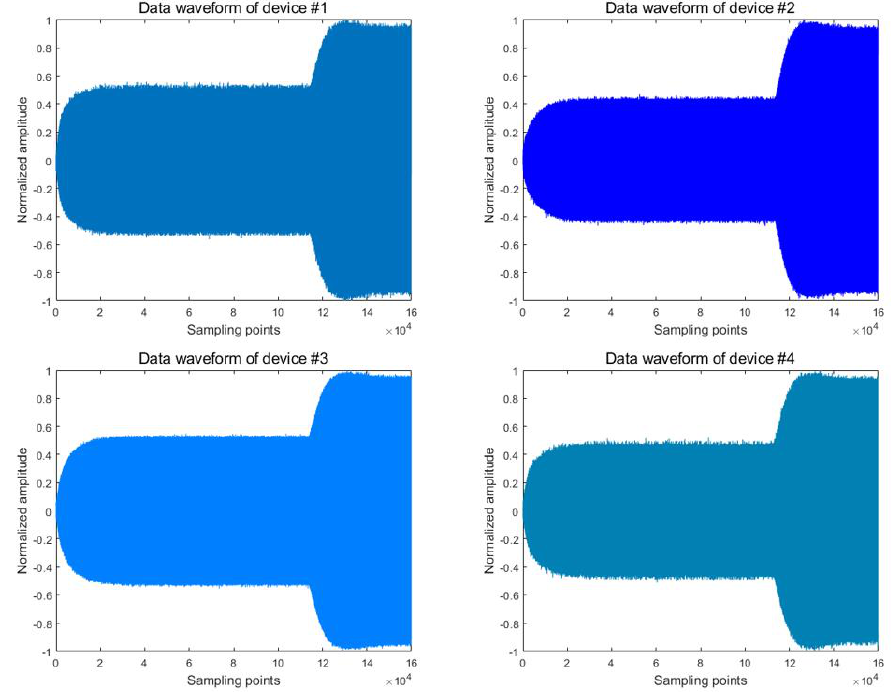
Figure 3. Transient signal waveforms of four wireless